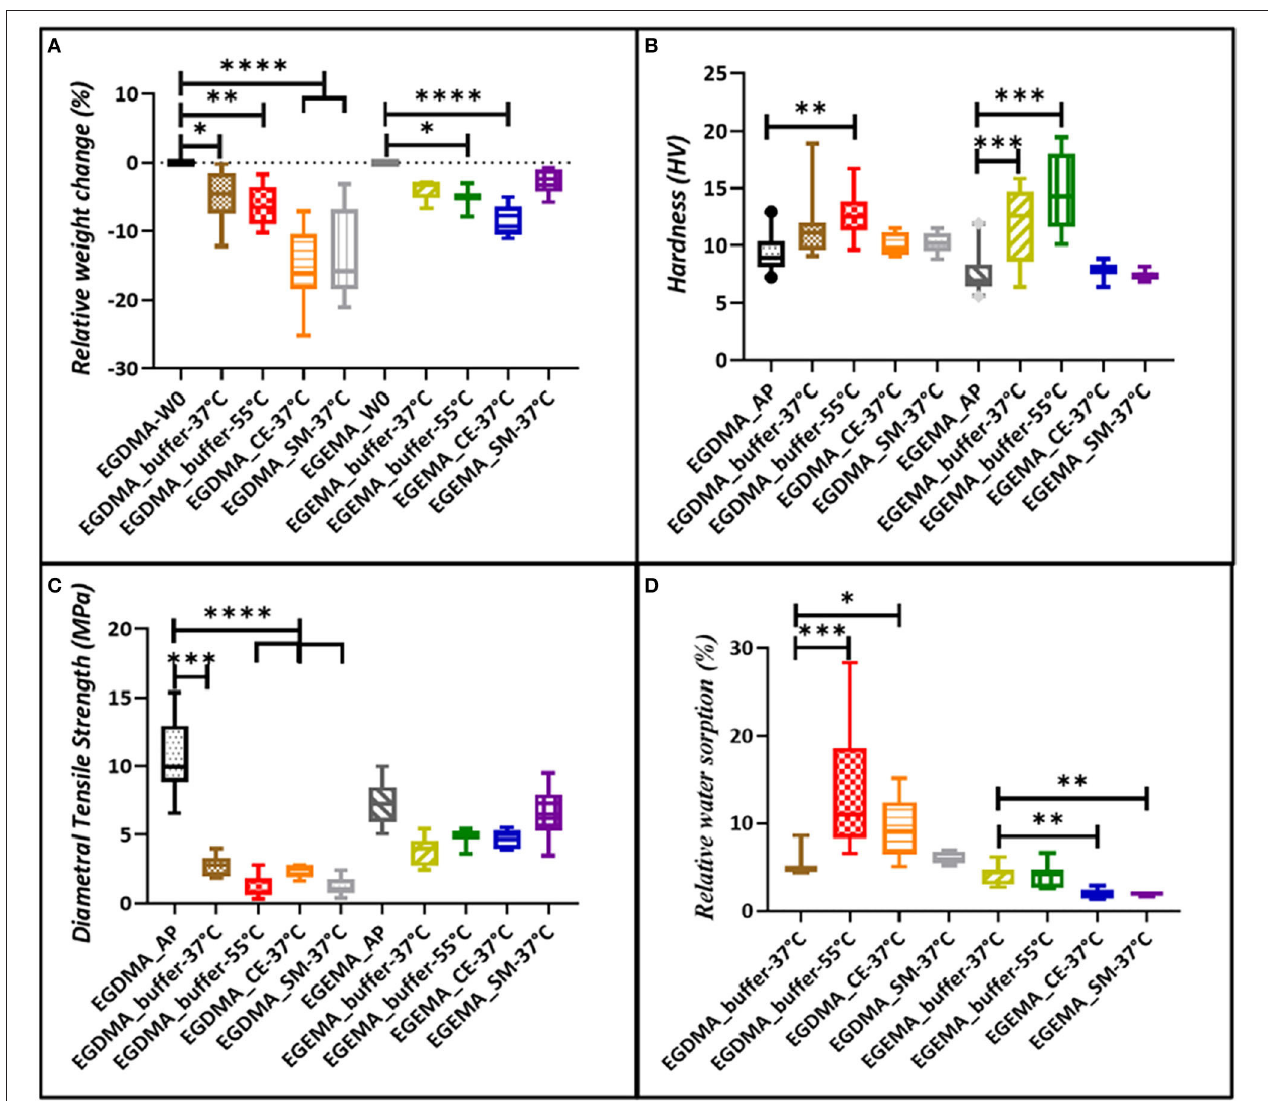
FIGURE 2 | Relative weight change for sample discs incubated in buffer, CEase and S. mutans cells, (A) followed by change in hardness (B) for same conditions, (C) represents changes in diametral tensile strength, and (D) represents relative water sorption. Graphs based on data presented in reference (28, 30,